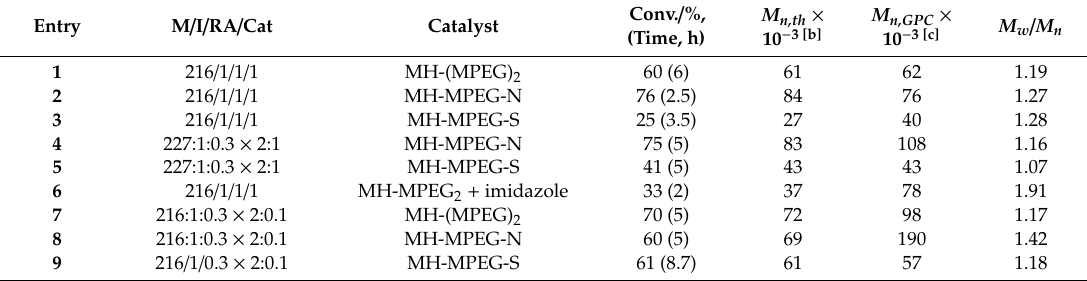
Table 1. Experimental conditions and results of ATRP catalyzed by axially ligated mesohemins [a].